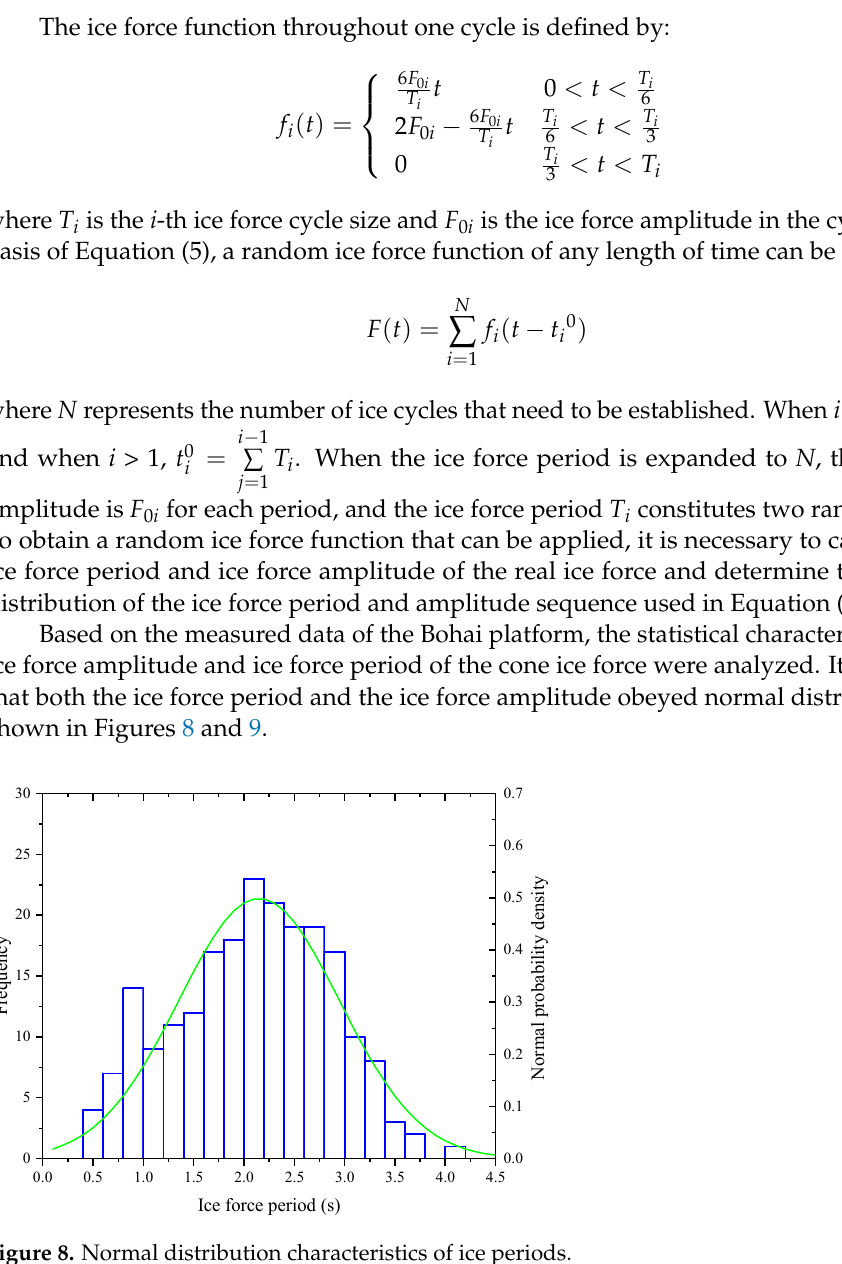
The ice force function throughout one cycle is defined by: